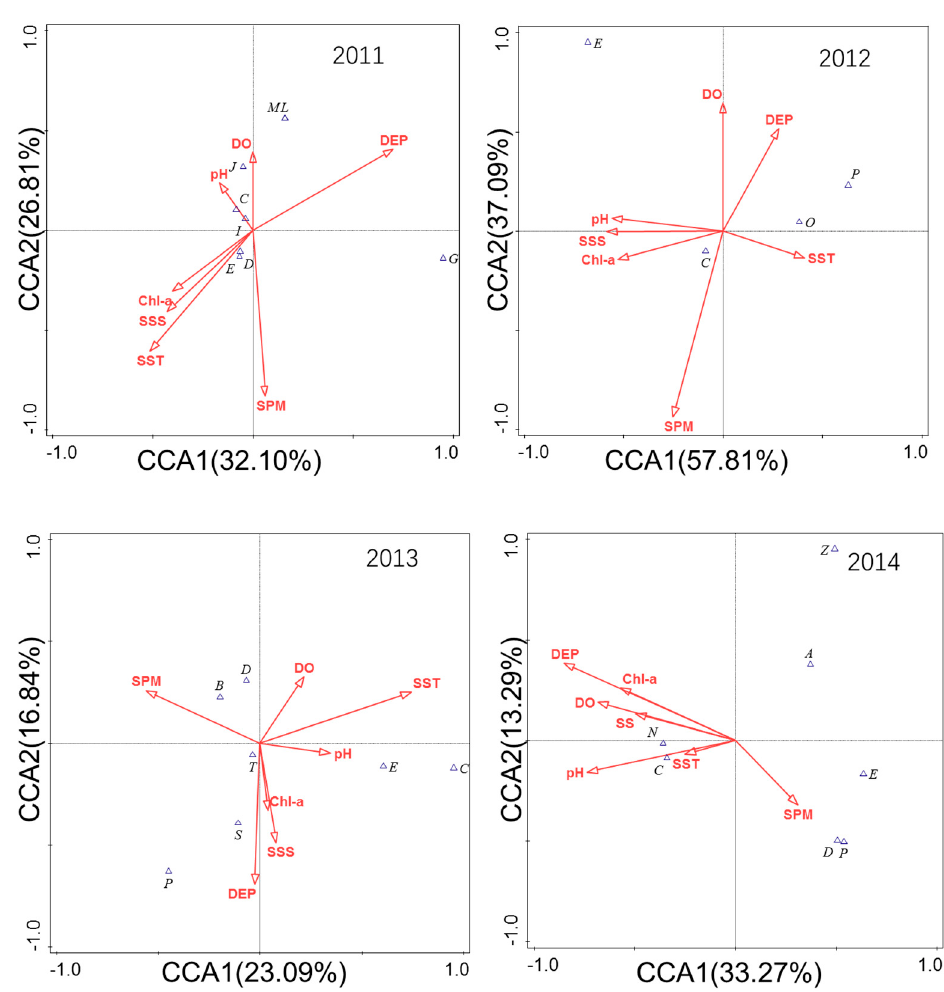
Figure 9. CCA ranking of the main species of fish eggs and larvae with environmental factors. SST = sea surface temperature, SSS = sea surface salinity, DEP = depth, DO = dissolved oxygen, Chl − a = chlorophyll − a, SPM = suspended particle matter, pH = acidity.